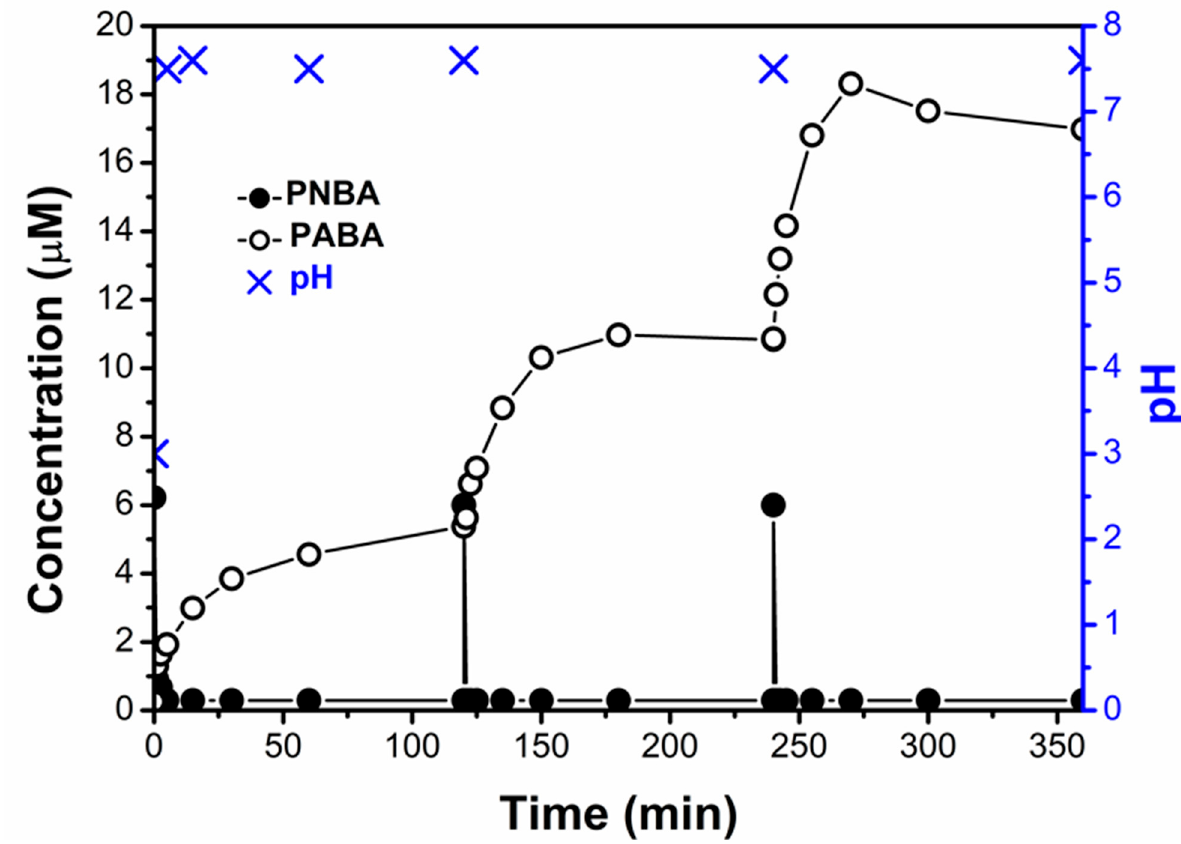
Figure 3. Three consecutive reductions of PNBA 6 µM (additions each 120 min) in NW with 1.4 g/L of mZVI and initial pH 3.0.